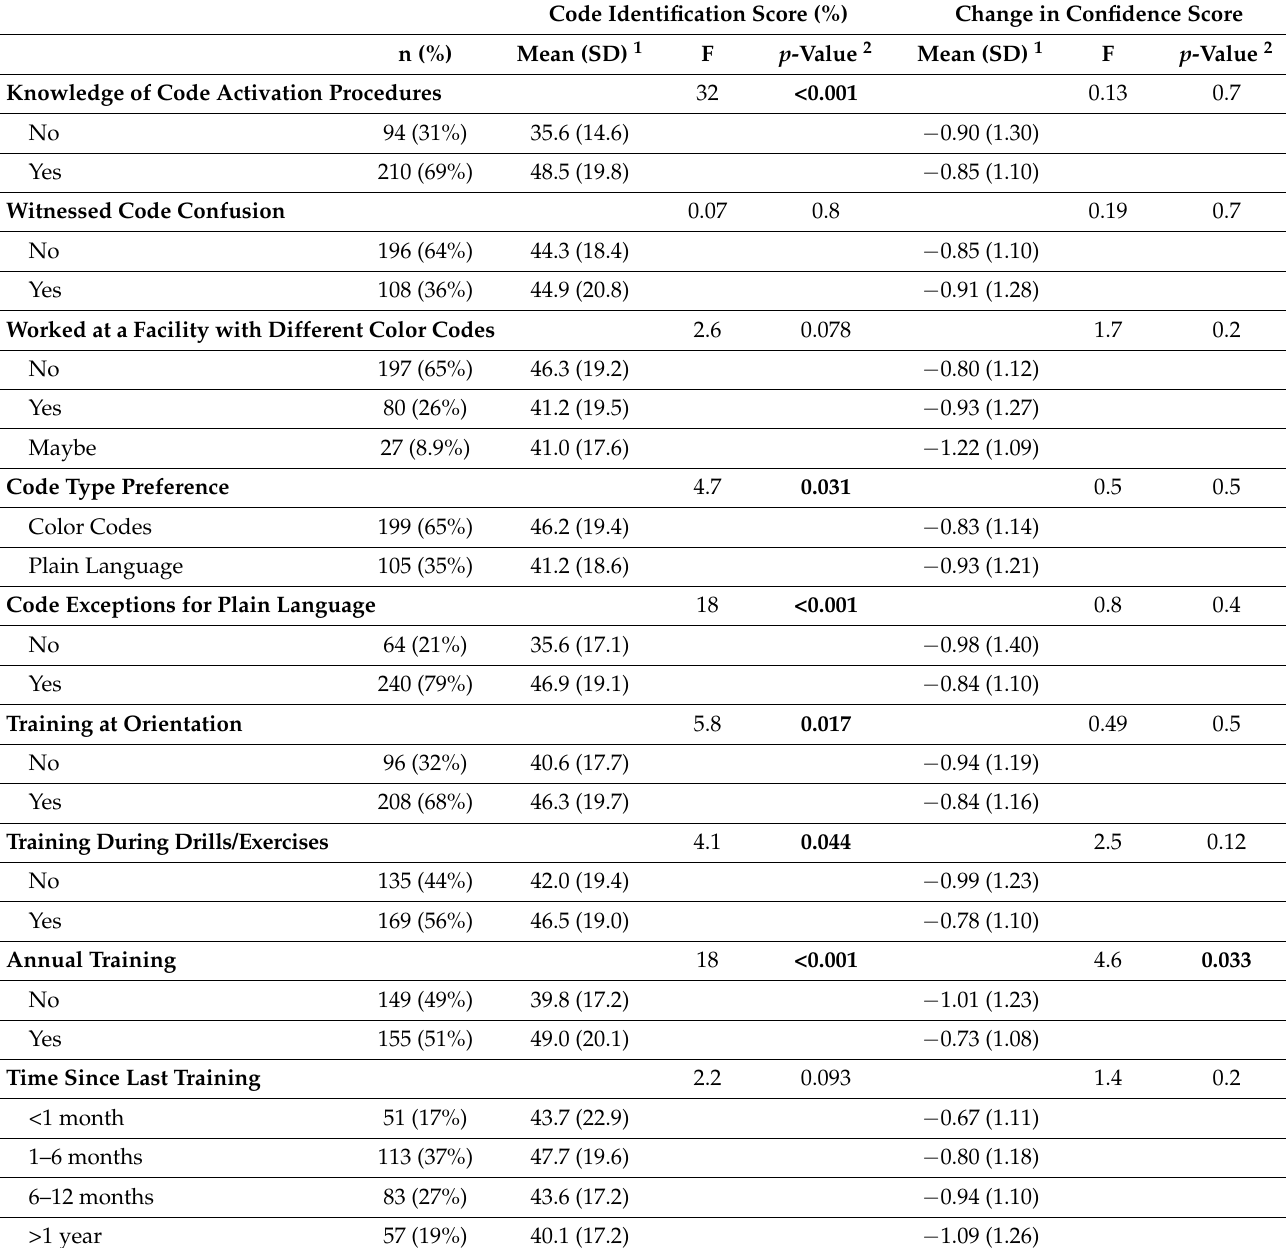
Table 5. Results of experience with emergency codes one-way ANOVA tests with code identification and change in confidence score (N = 304). Significant p -values ( ≤ 0.05) are bolded. Code Identification Score